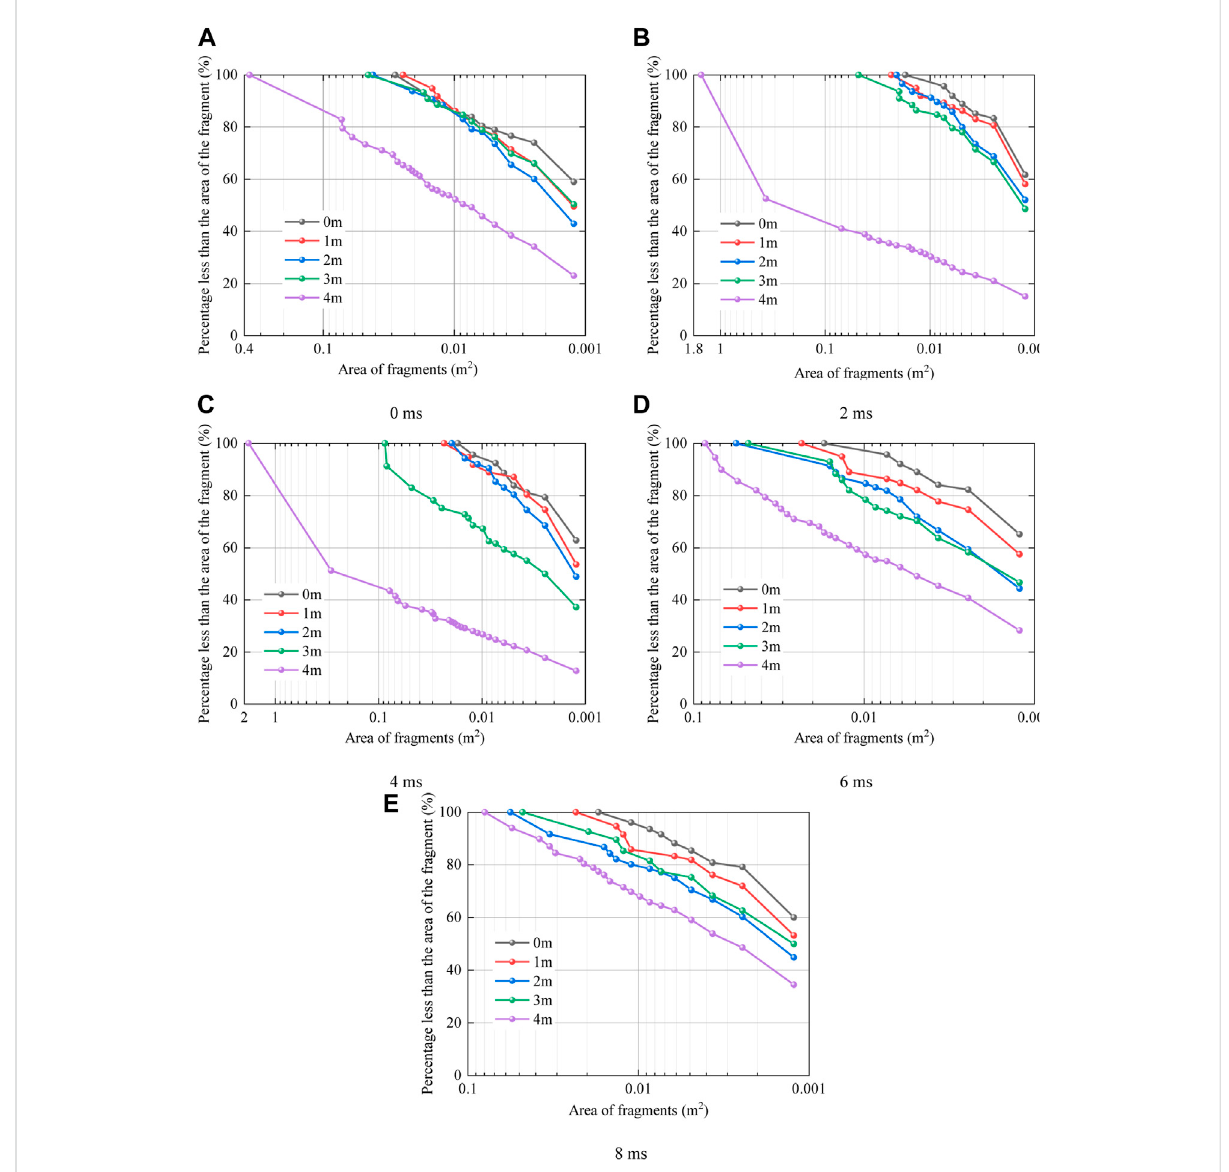
FIGURE 6 Fragment gradation curves under hard rock initiation, (A) 0 ms, (B) 2 ms, (C) 4 ms, (D) 6 ms, (E) 8